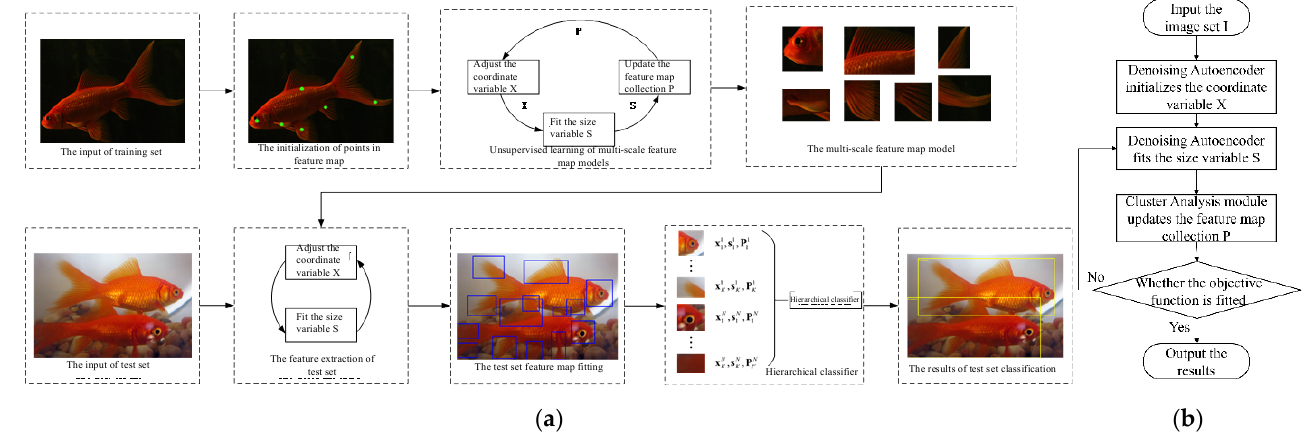
Figure 6. The process of the feature extraction module. The left picture ( a ) is an example using a multi-scale feature-based fish detection algorithm. The right picture ( b ) is the flowchart of the algorithm. The structure of denoising autoencoder is shown in Figure 4, and the steps of cluster analysis are shown in Figure 5.